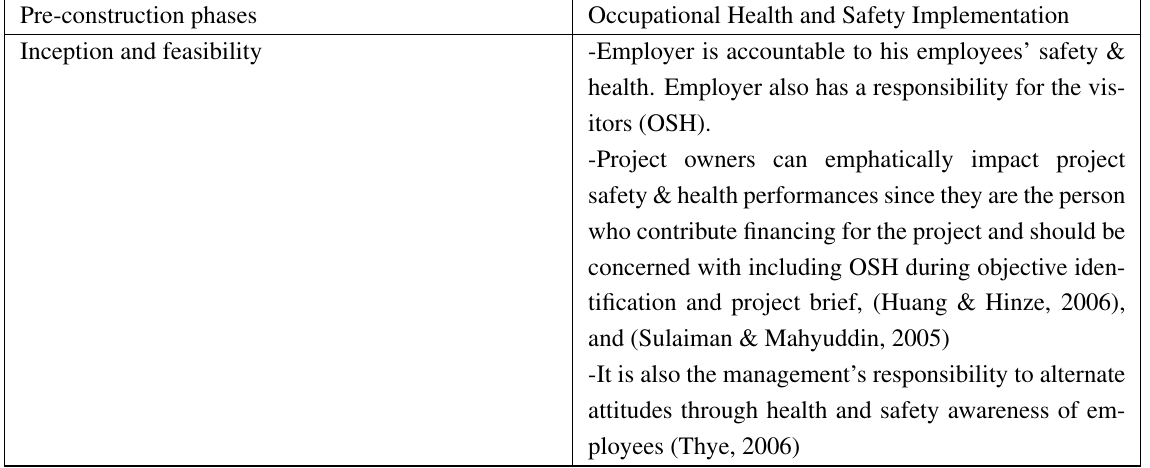
Table 3. OccupationalHealth and Safety Implementation in Pre-construction phases, author afterextant